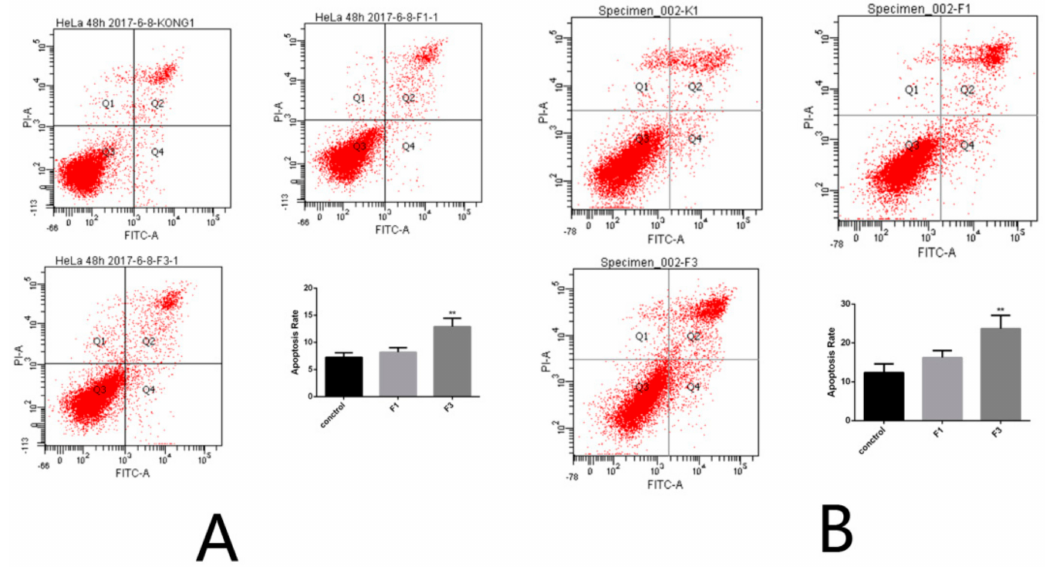
Figure 8. The apoptosis rate of HeLa cells after treatment with F1 and F3 for ( A ) 24 h and ( B ) 48 h. 2.6. Morphology Changes in HeLa Cells after Treatment with F1 and F3 for 24 h and 48 h